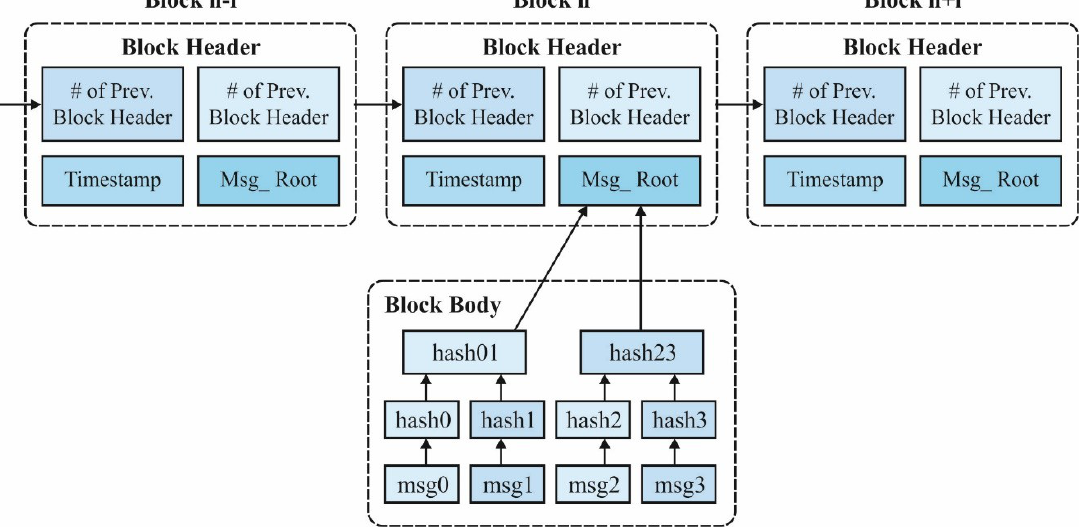
Figure 4. Structure of a blockchain.